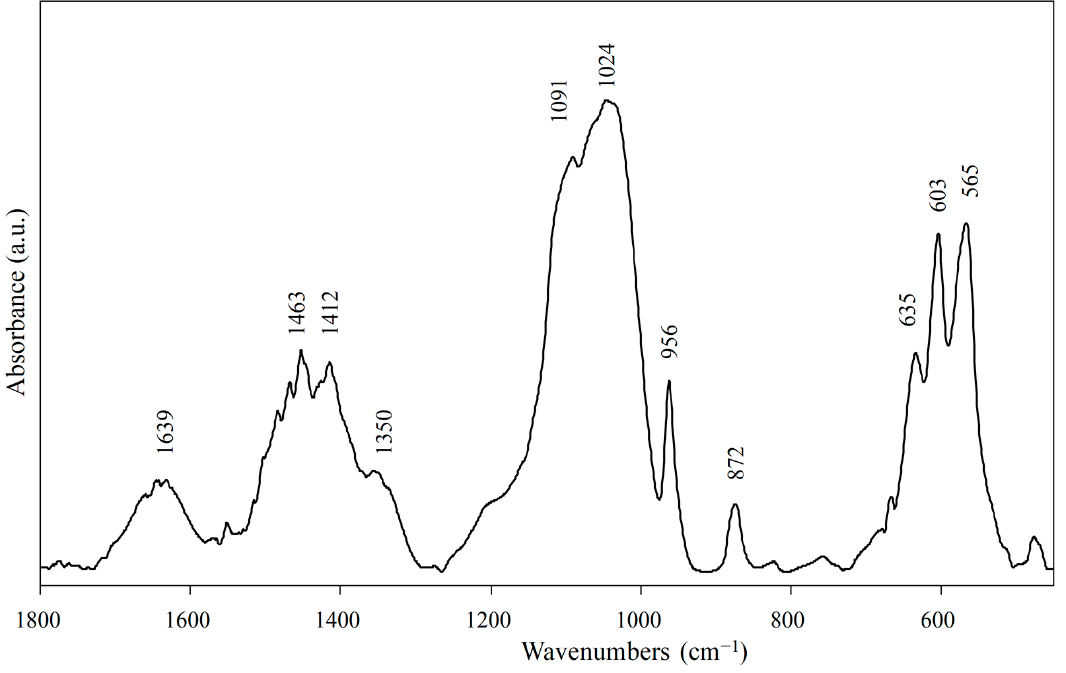
Figure 2. ATR–FTIR spectrum of a representative human bone sample from the Fewet oasis in the Sahara of SW Libya. The spectrum is displayed in the 1800–500 cm − 1 region; the positions of the most relevant peaks (in terms of wavenumbers, cm − 1 ) are reported for clarity.